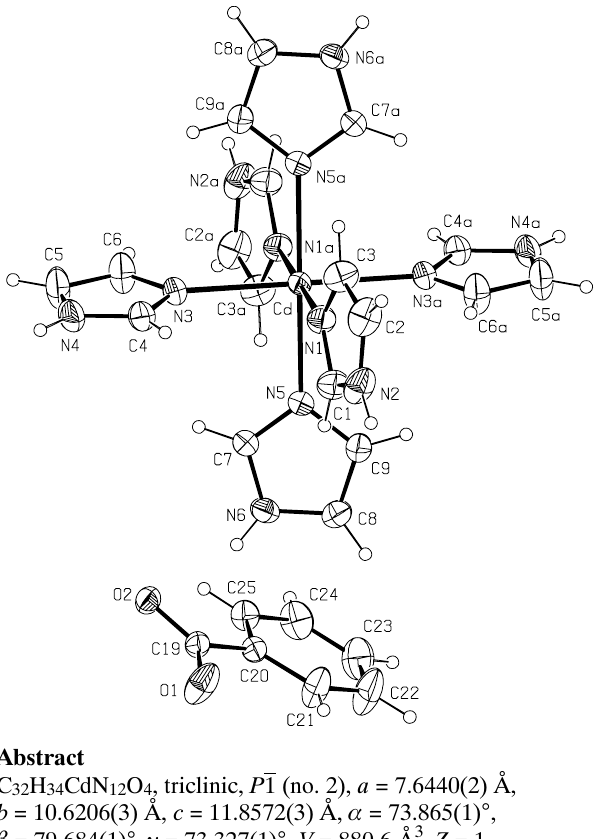
Discussion The title compound crystallizes isotypically with the cobalt ana- logon [1]. The cadmium atom takes sp 3 d 2 configuration to be co- ordinated by six nitrogen atoms of six imidazole molecules. The